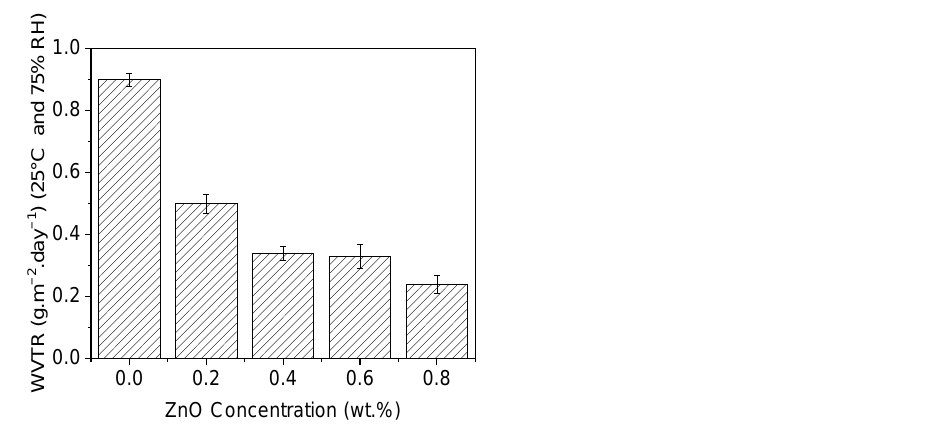
Figure 8. Water vapor transmission rate (WVTR) at conditions of 25 °C and 75% RH versus ZnO weight concentration.